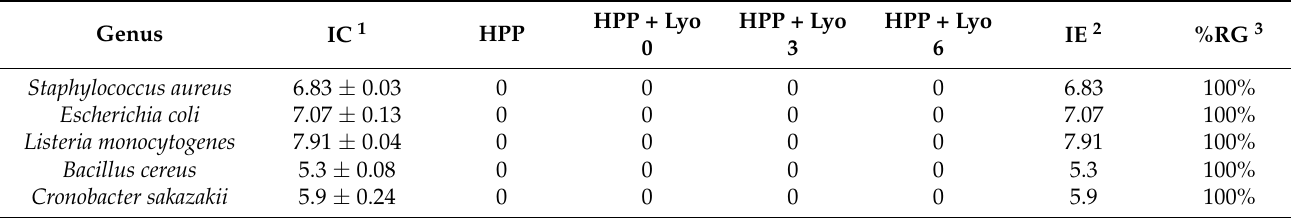
The data are presented as mean values with the standard error of the mean. 1 IC—initial concentration; 2 IE—inactivation efficiency (the decrease in bacterial growth by orders of magnitude after HPP and HPP + Lyo compared with IC); 3 %RG—the percentage reduction of bacterial growth compared with